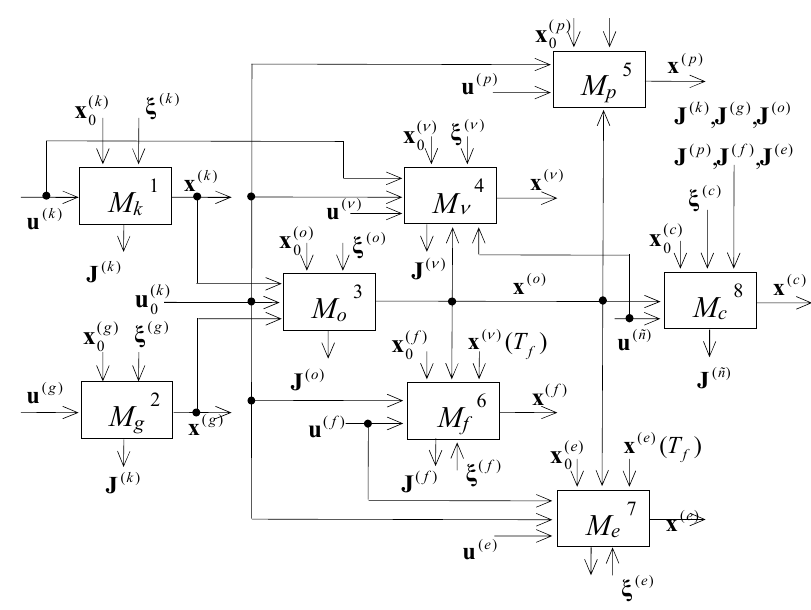
Figure 1. The scheme of optimal program control model interconnection.